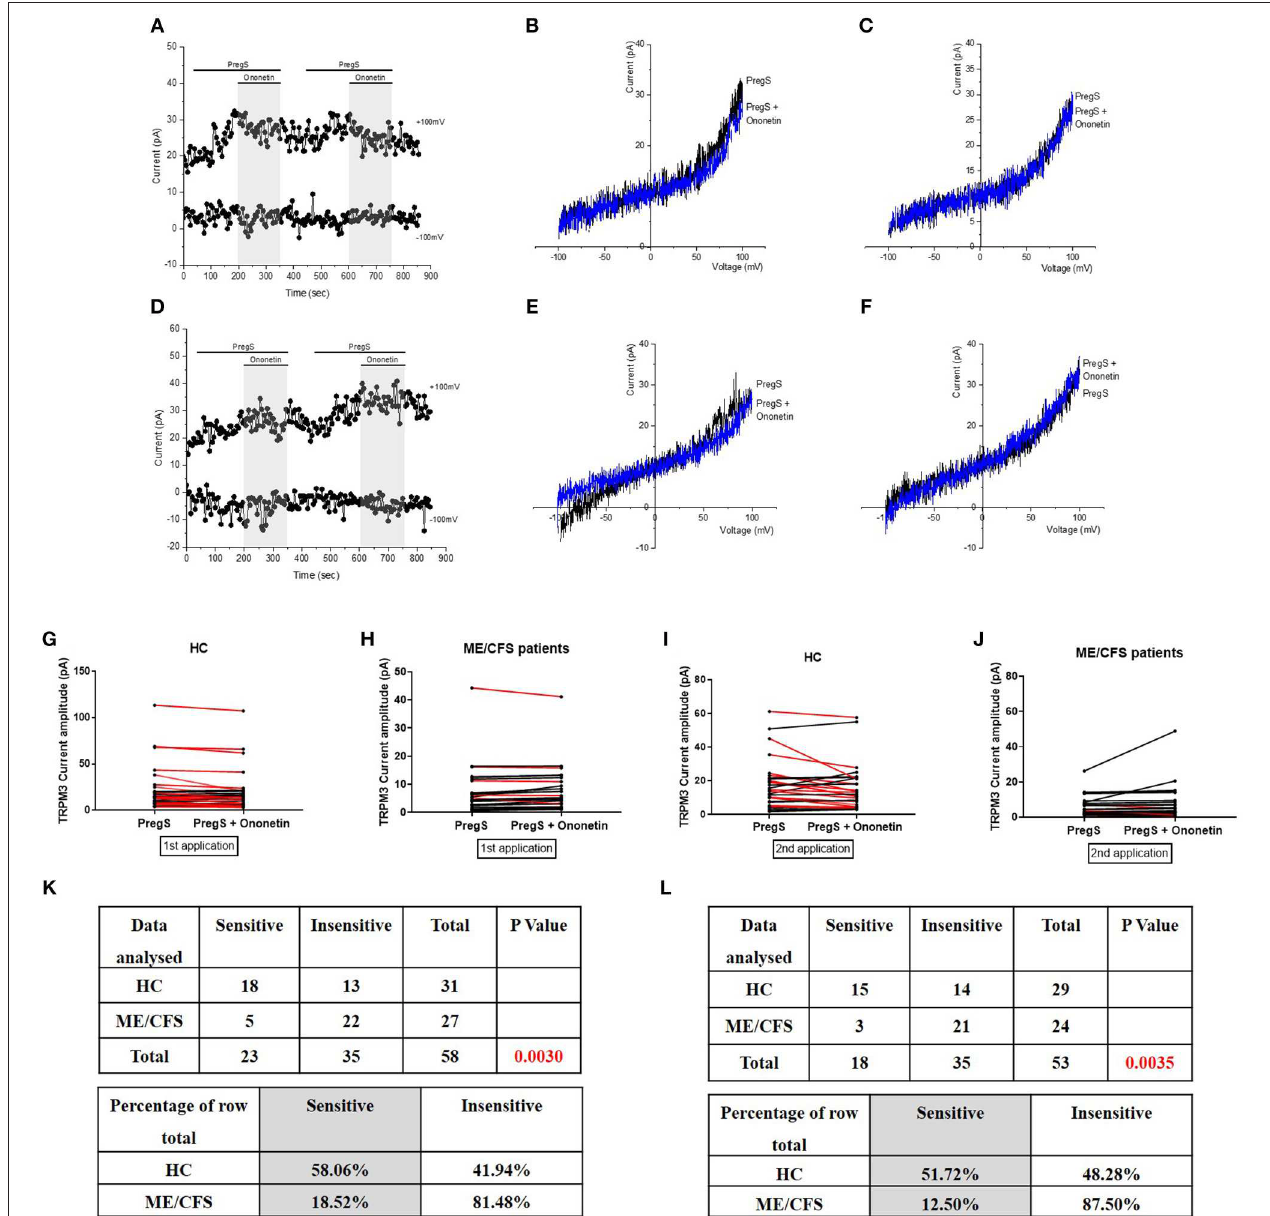
FIGURE 3 | Modulation of PregS- evoked currents with Ononetin. Data were obtained under whole-cell patch clamp conditions. (A) A representative time-series of current amplitude at + 100mV and − 100mV showing the effect of 10 µ M ononetin (gray) on ionic currents in the presence of 100 µ M PregS in IL-2 stimulated NK cells from HC. (B) I – V before and after the first application of ononetin in the presence of PregS in a cell as shown in (A). (C) I – V before and after the second application of ononetin in the presence of PregS in a cell as shown in (A). (D) A representative time-series of current amplitude at + 100mV and − 100mV showing the effect of 10 µ M ononetin (gray) on ionic currents in the presence of 100 µ M PregS in IL-2 stimulated NK cells ME/CFS patients. (E) I – V before and after the first application of ononetin in the presence of PregS in a cell as shown in (D) . (F) I – V before and after the second application of ononetin in the presence of PregS in a cell as shown in (D). (G,H) Scatter plots representing change of each current amplitude before and after the first application of ononetin in presence of PregS in all NK cells from HC and ME/CFS patients. Each cell represented as red lines had reduction in currents by ononetin. (I,J) Scatter plots representing change of each current amplitude before and after the second application of ononetin in presence of PregS in all NK cells from HC and ME/CFS patients. Each cell represented as red lines had reduction in currents by ononetin. (K) Table summarizing data for sensitive and insensitive cells to the first application of 10 µ M ononetin in presence of PregS in HC ( N = 8; n = 31) compared to ME/CFS patients ( N = 8; n = 27). (L) Table summarizing data for sensitive and insensitive cells to the second application of 10 µ M ononetin in presence of PregS in HC ( N = 8; n = 29) compared to ME/CFS patients ( N = 8; n = 24). Data are analyzed with Fisher’s exact test. ME/CFS, myalgic encephalomyelitis/chronic fatigue syndrome; HC, healthy controls; NK, natural killer; PregS, Pregnenolone sulfate; TRPM3, Transient Receptor Potential Melastatin 3.